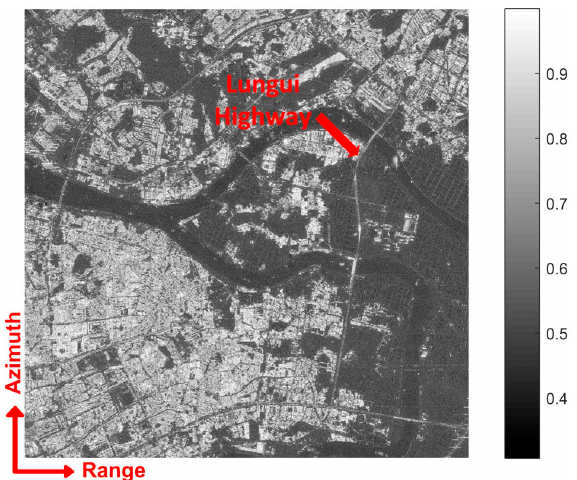
Figure 5. Temporal and perpendicular baselines of the final selected InSAR pairs (X axis defines the temporal baseline, Y axis defines the perpendicular baseline. Number 0–16 define the corresponding TerraSAR images in our article, the yellow point 7 is the super master image selected, the red pillar areas are the gaps, not covered by any suitable interferometric pairs).